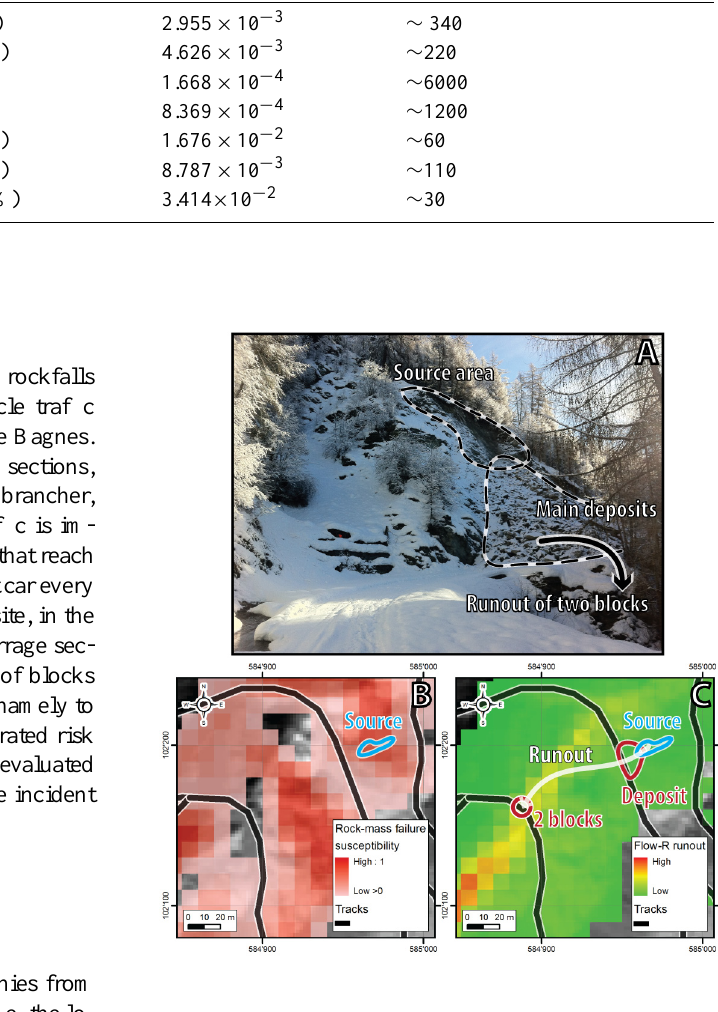
Fig. 10. (A) A recent rockfall event (2 January 2012) cut a mountain road with a deposit of approx. 1000m 3 . The height difference between the fresh scarp and the road is about 30m. (B) The rock-mass failure susceptibility map indicates that the onset is clearly defined as a potential rockfall source area with an high rock-mass failure susceptibility of about 0.8. (C) The trajectory of two blocks that reached a second road 80m lower fit well with the predicted runout and confirms Flow-R results. (Hillshade: ©2008 swisstopo)